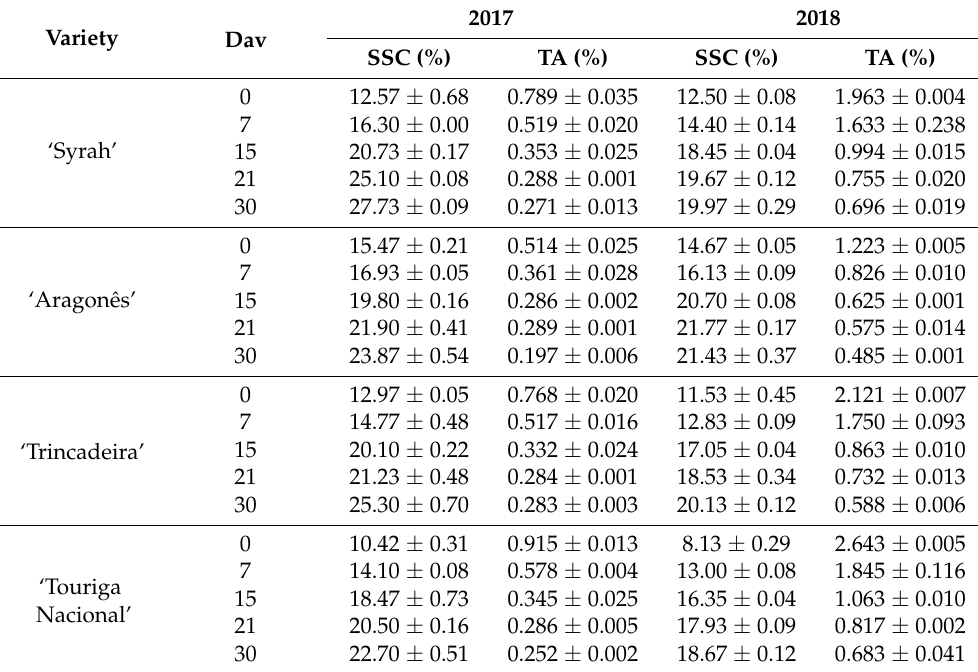
Table 1. Mean ± standard deviation (SD) of SSC and TA in grape berries from samples collected in 2017 and 2018 in the days after v é raison